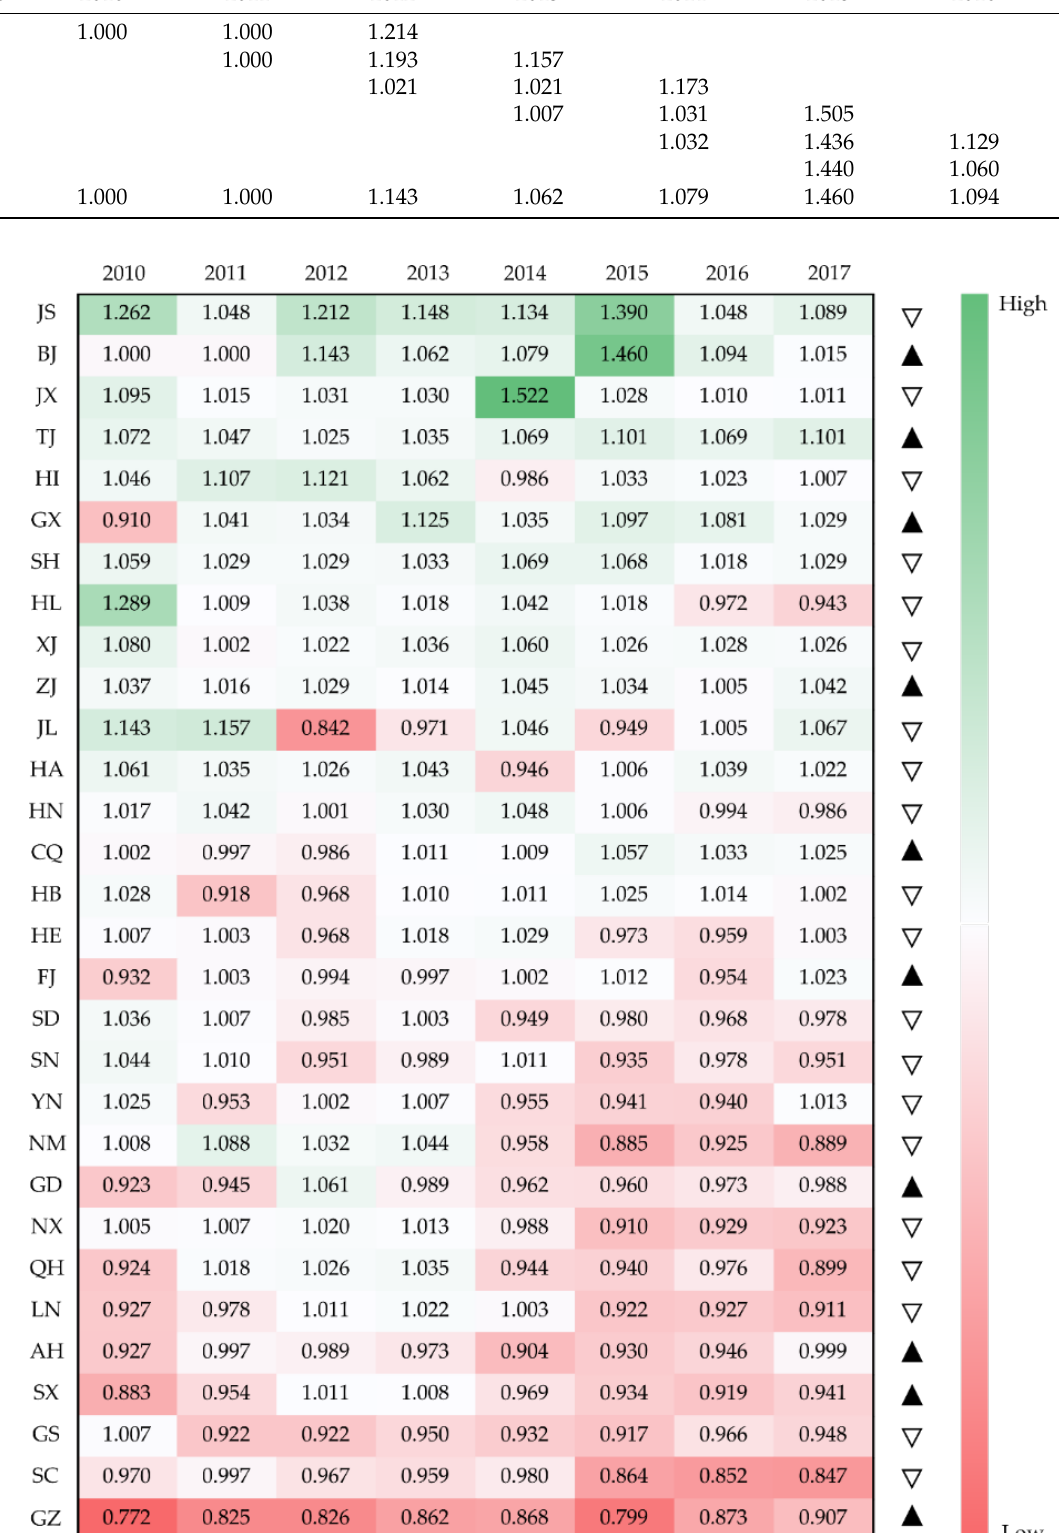
Table 2. The calculation process for the SPCI in BJ.